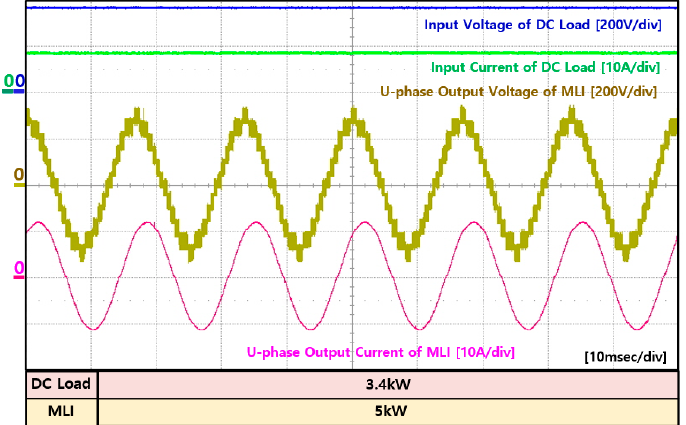
Figure 23. Experiment waveforms of interfacing converter at AC grid in mode 4.